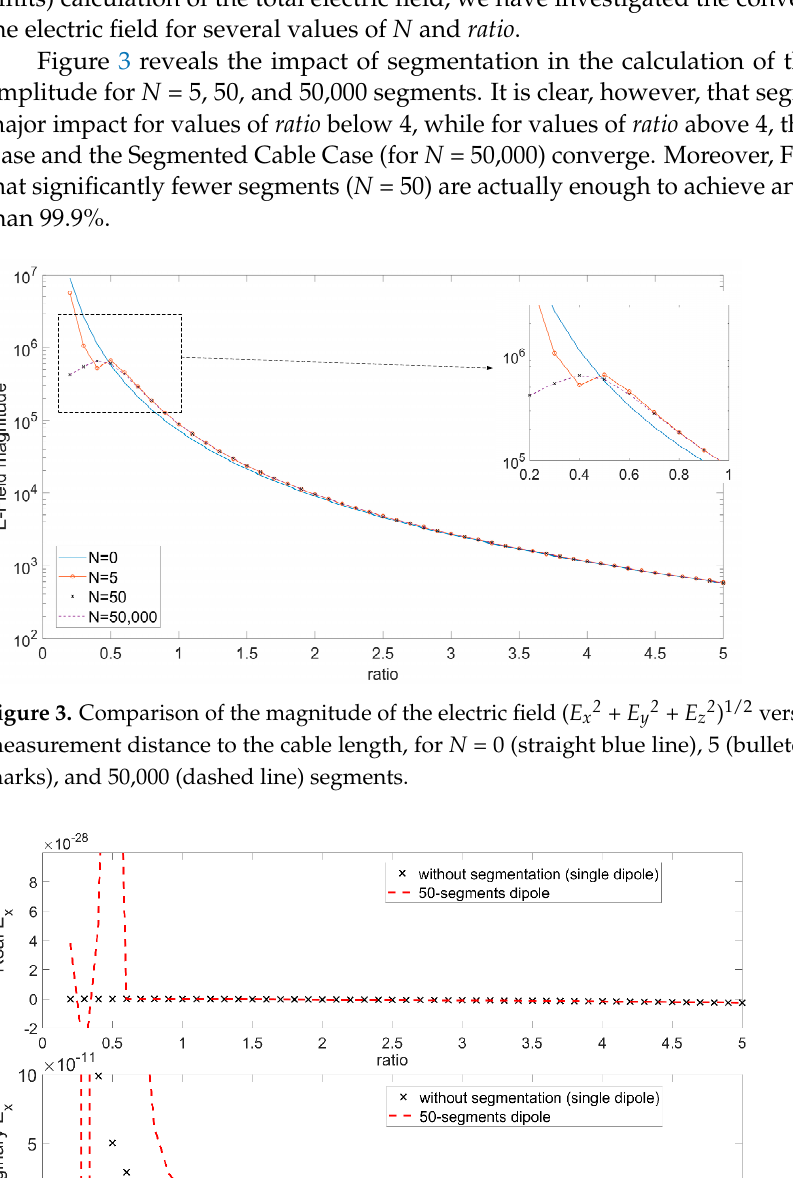
Figure 5. Comparison of the real and imaginary parts of the electric field component E x versus the ratio of the measurement distance to the cable length, for the Single Dipole Case (circles), the Seg- mented Dipole Case for N = 50 segments (dashed lines), and the Single Dipole Case with Near Field Approximation (x marks).